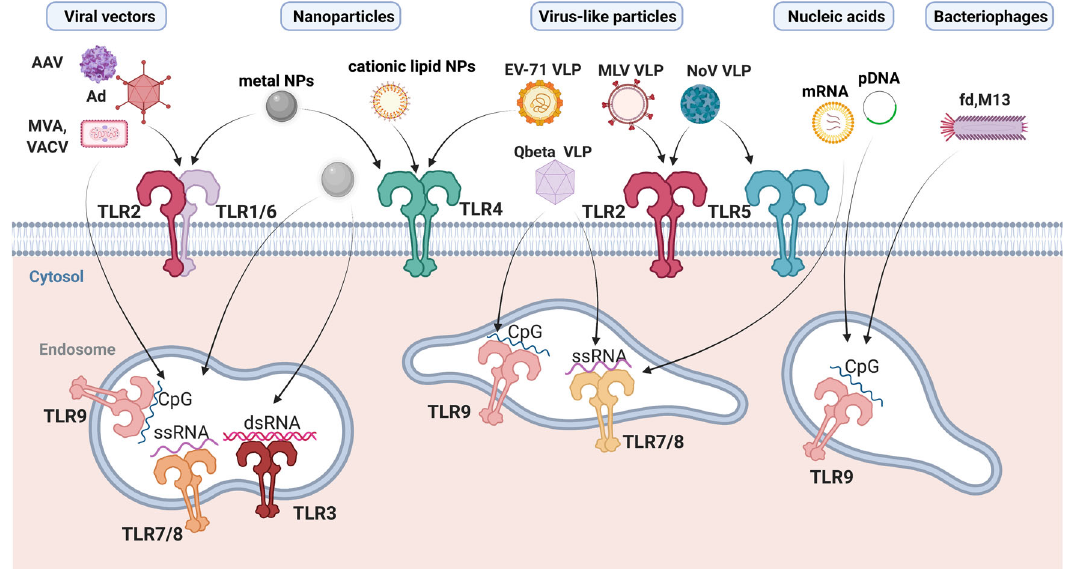
Fig. 4 TLR sensing of viral patterns within vaccines. Viral motifs such as Env proteins, RNA, or DNA of AAV, Ad, and vaccinia viral vectors can bind and trigger the cell surface TLR2 and the endosomal TLR3, TLR7, TLR8, and TLR9 sensors, while speci fi c structures of VLP capsids can be sensed by TLR2, TLR4, and TLR5, as described for NoV, MLV, and enteroviruses. In some cases, the self-packaging of nucleic acids during VLP assembly can lead to TLR7/8 and TLR9 activation. Metal NPs can be sensed by TLR3, TLR4, TLR6, and TLR7, depending on their composition, while lipid-based NPs can be recognized via TLR2 heterodimers. Nucleic acid-based vaccines (i.e., naked plasmid DNA or liposome- encapsulated mRNA vaccines) trigger TLR7/8 or TLR9 pathways. As natural nanoparticles, bacteriophages are internalized by immune cells and can reach endosomal compartments, where their nucleic acids are sensed by intracellular TLRs. Filamentous phages, like M13 and fd, can activate TLR9 via CpG-rich DNA sequences. Created with